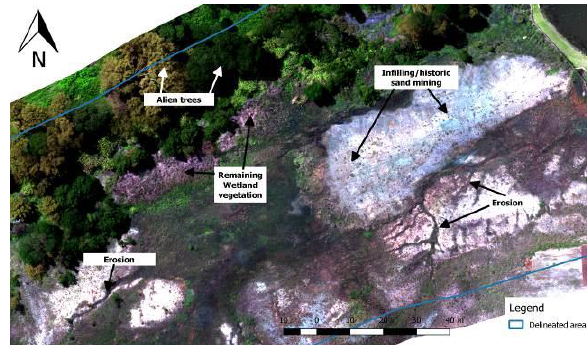
Figure 9. Determination of extent and intensity of disturbance classes from the UAV orthomosiac.